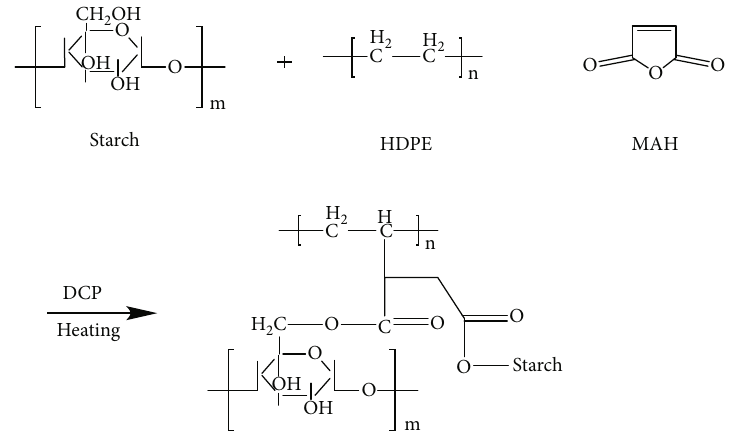
Scheme 1: Schematic representation of synthesis procedure for MA grafting STR/HDPE.